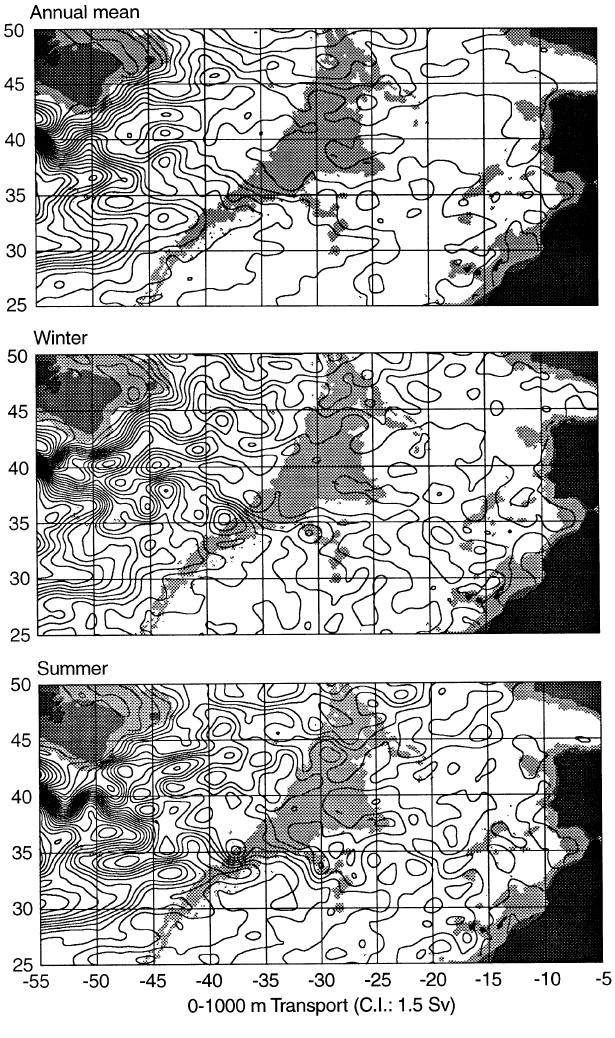
Fig. 4. Average transports between 0 and 1000 m as predicted by the model: yearly average, winter semi-annual average and summer semi- annual average (CI: 1.5 Sv). Shading corresponds to the regions where the depth is less than 3000